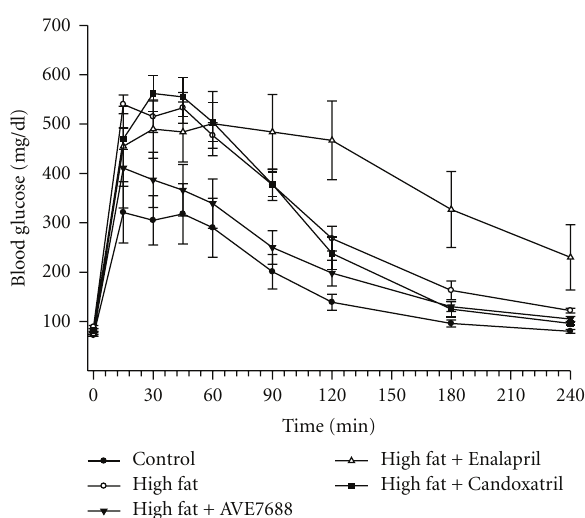
Figure 1: E ff ect of a high-fat diet and treatment with AVE7688 on glucose tolerance. Rats were fed a standard or high-fat diet with or without AVE7688, Enalapril, or Candoxatril for 24 weeks. Afterwards glucose tolerance was determined as described in Section. Data are presented as the mean ± SEM in mg/dL. The area under the curve (AUC) was significantly di ff erent P < . 01 for high-fat fed rats versus control. There was no significant di ff erence for AUC between rats fed a high-fat diet containing AVE7688 and control or high-fat fed rats. Feeding rats a high-fat diet containing Enalapril or Candoxatril provided no improvement in impaired glucose tolerance caused by the high-fat diet. The number of rats in each group was the same as shown in Table